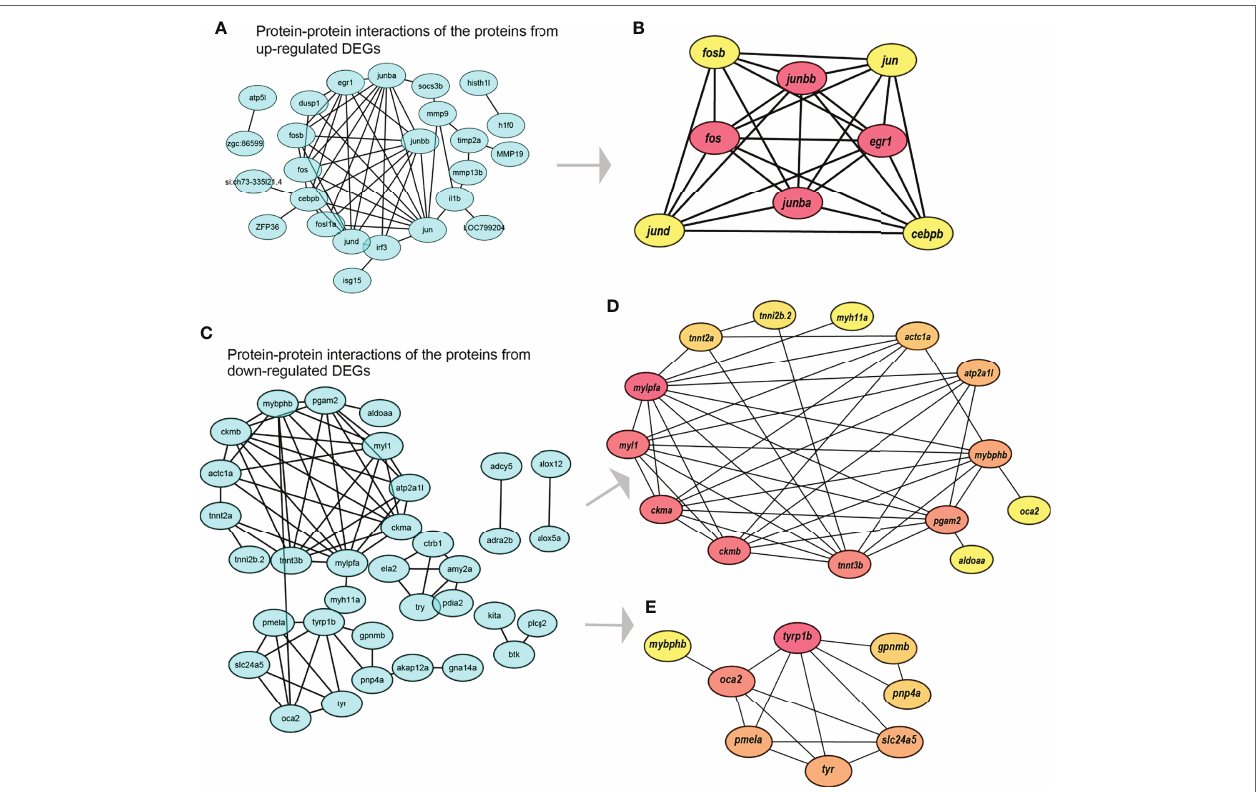
FIGURE 4 | Construction of the protein-protein interaction (PPI) networks along with identification of key functional modules and hub genes. (A) The PPI network of those proteins derived from upregulated DEGs; (B) The identified key functional module and hub genes in (A) ; (C) The PPI network of those proteins derived from downregulated DEGs; (D) The first key functional module and hub genes in (C) ; (E) The second key functional module and hub genes in (C)